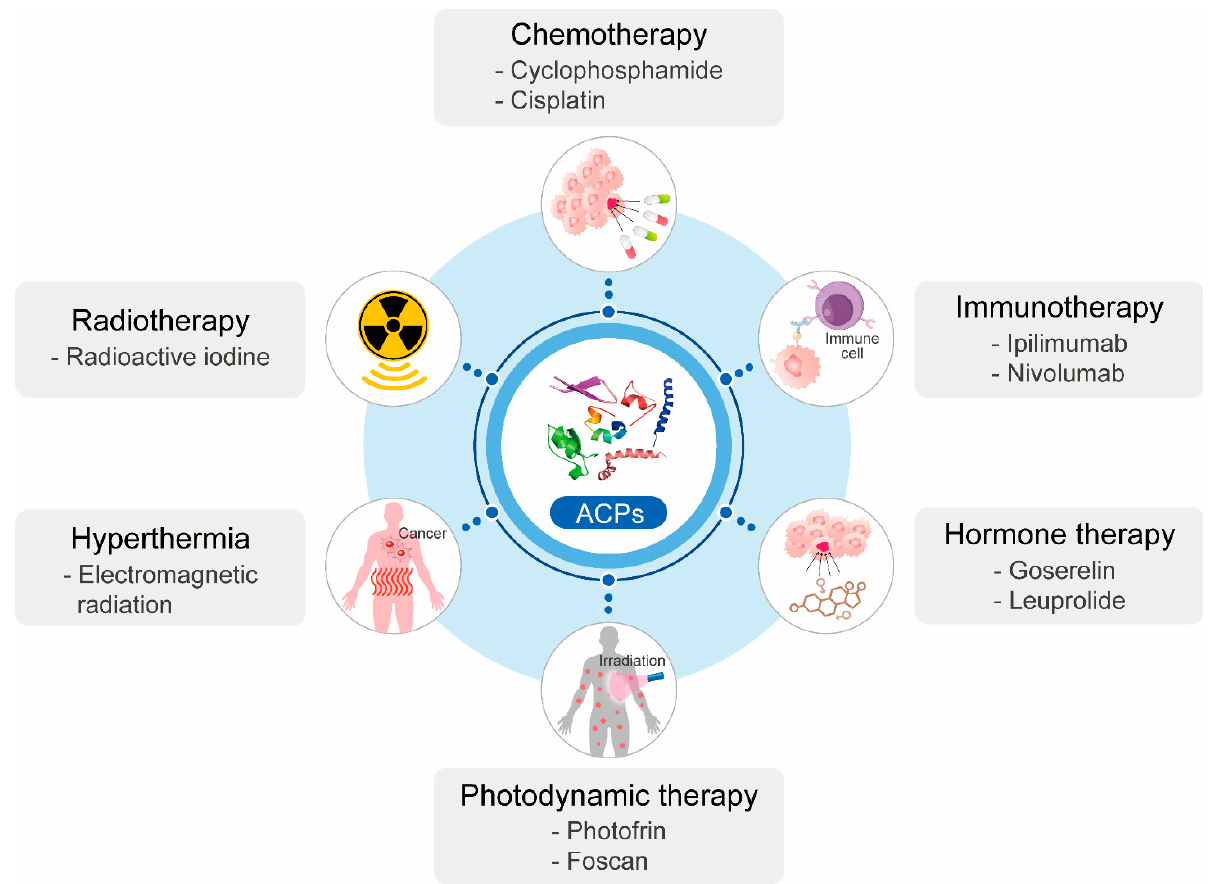
Figure 5. Combinational therapy of ACPs with other cancer therapies.